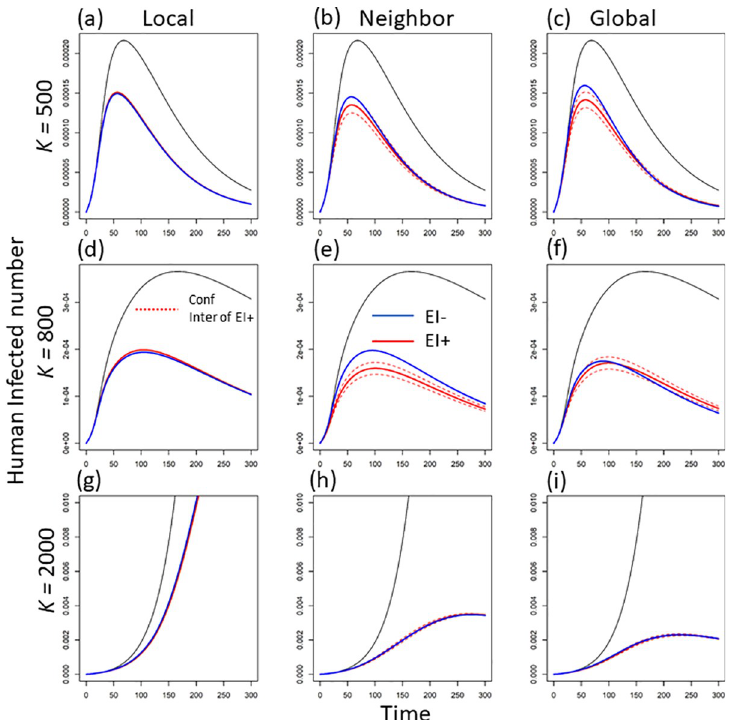
Fig 3. The dynamics of human infections (unit: no.) per patch under three levels of mosquito breeding capacity (e.g., K = 500, 800 and 2000) and three scales of disease information (i.e., local, regional, and global scale). Here we exclude the patch where disease starts to get the average infected human number in one patch. The blue lines indicate the dynamic in the absence of early intervention, while the red lines are the dynamics in the presence of early intervention (the dashed red lines are the 95% confidence interval